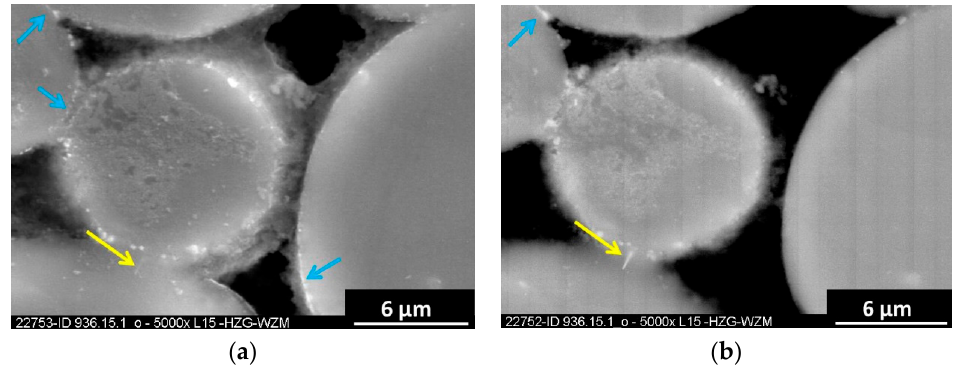
Figure 8. ( a ) SEM ‐ SE micrographs of thermal debound and sintered MIM specimens after 64 h sintering time using PE ‐ VA copolymer showing bright layers on the particles surface and sintering necks (see blue arrows) and a needle shape crystal slightly underneath the polished surface using 18 kV; ( b ) The needle shape structure inside of the sintering neck can be seen more clearly using backscattered electrons ‐ mode.